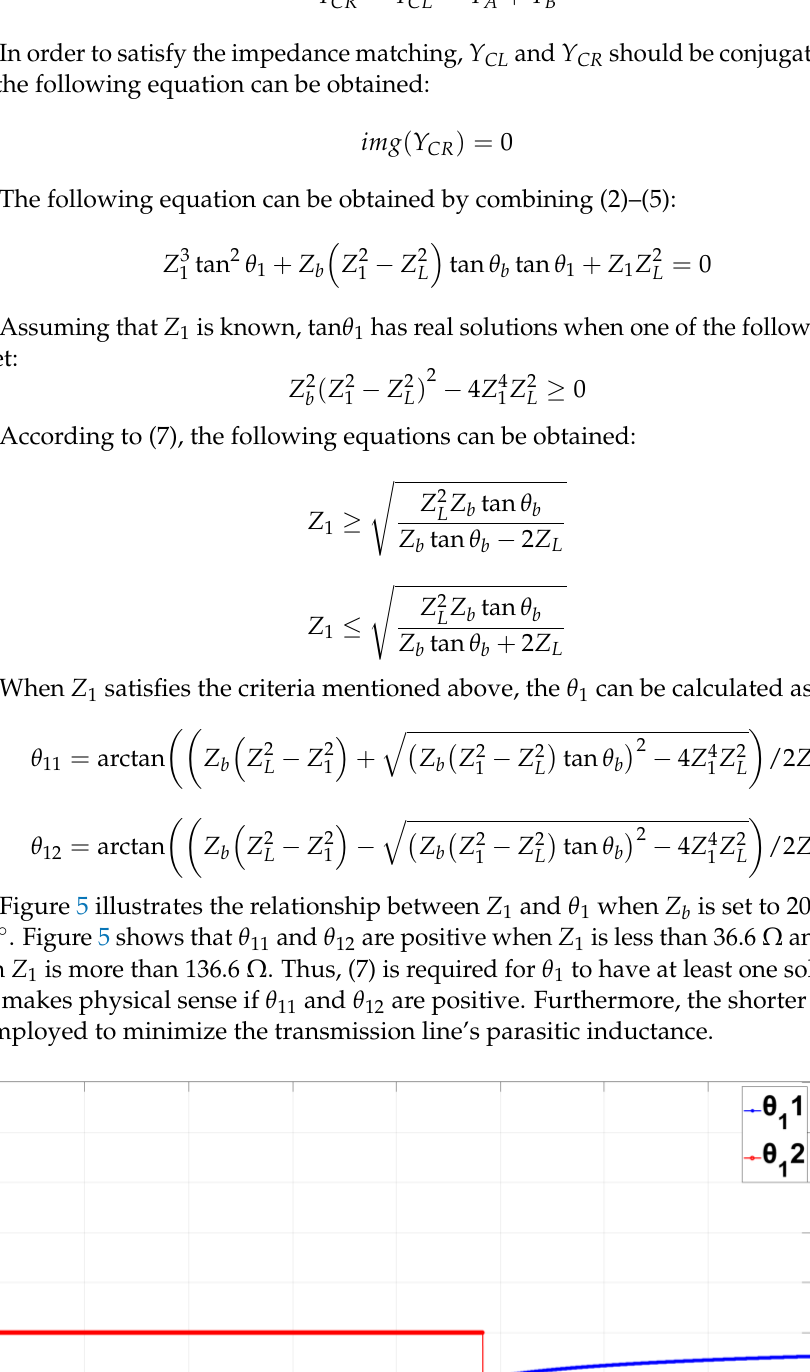
Figure 5. The relationship between Z 1 and θ 1 when Z b is set to 200 Ω and θ b to 30°.